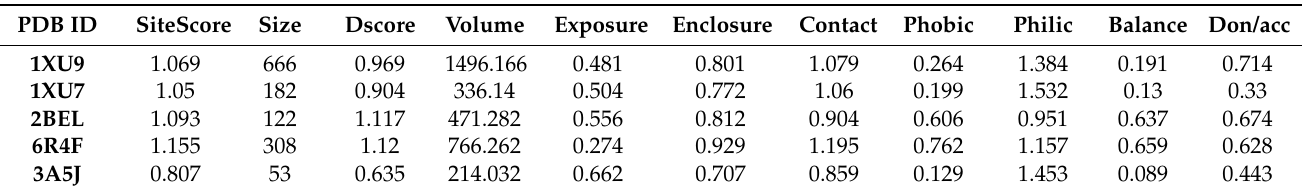
Table 3. Active site prediction of enlisted proteins using SiteMap. Only the top ranked scores are mentioned on the table for each